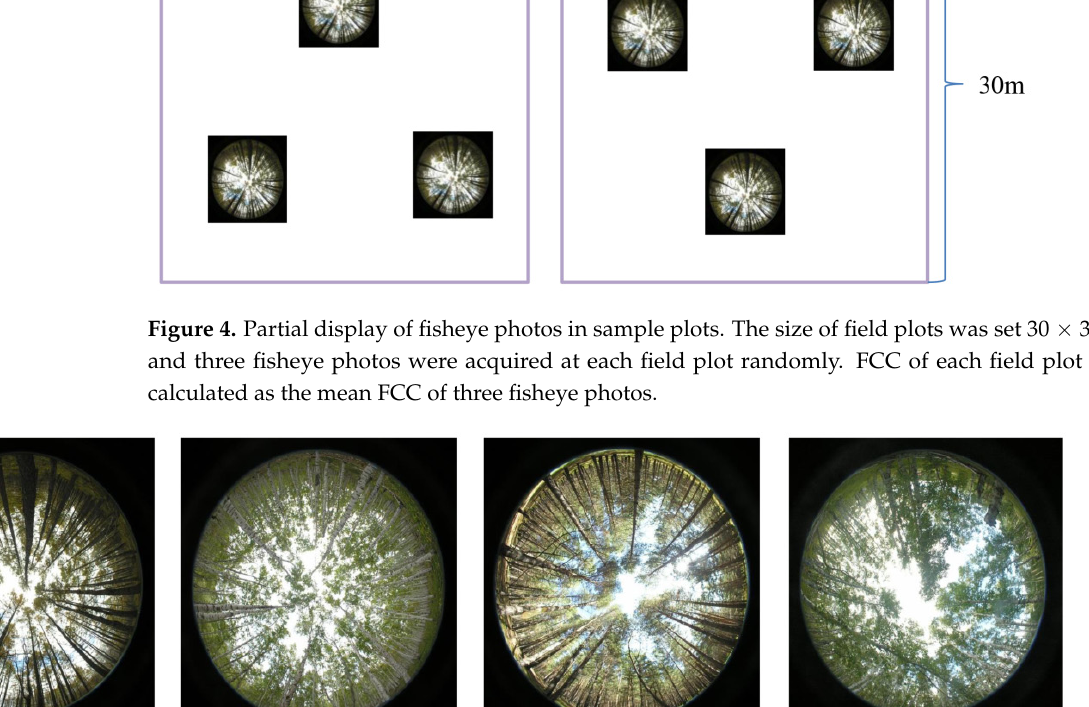
Figure 5. The presentation of different forest species in fisheye photos. The first and third photos were taken from camphor pine, and the second and fourth photos were taken from white birch.